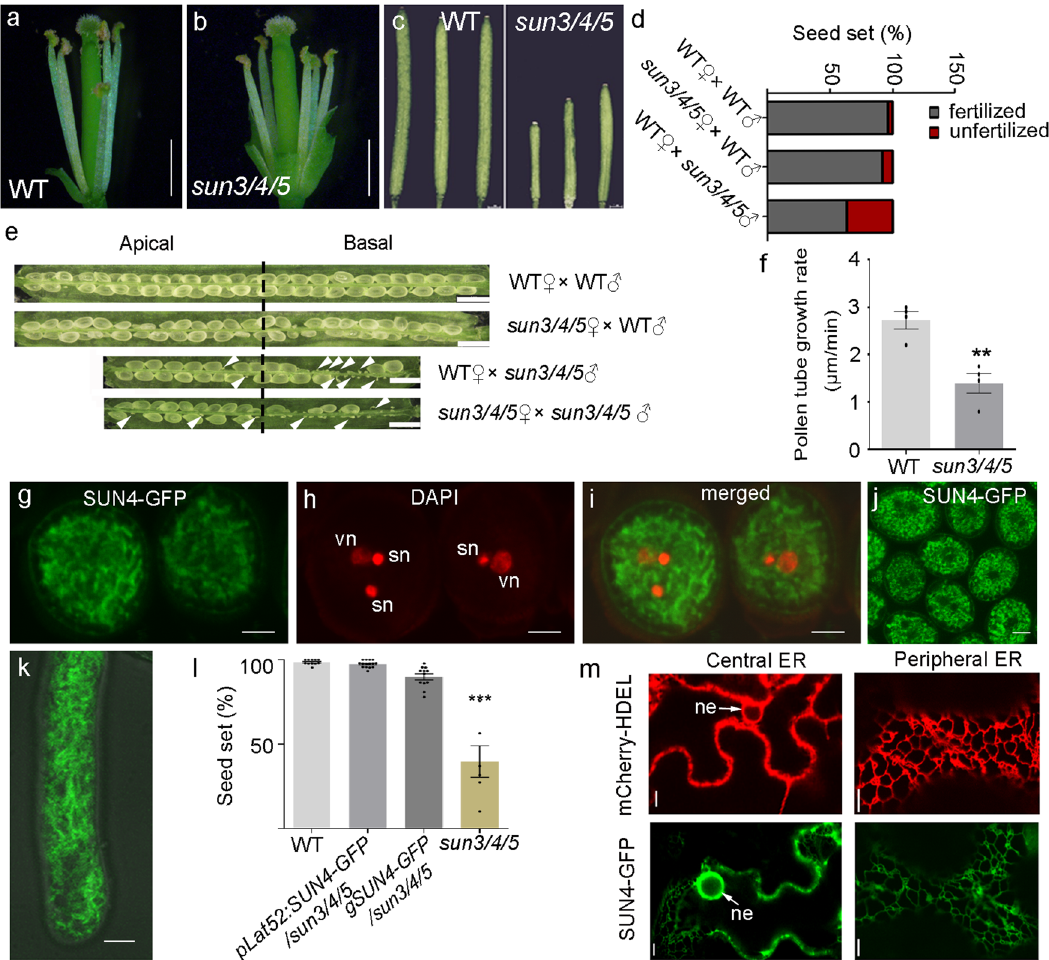
Fig. 2 Reproductive phenotype of sun3/4/5 . a Stamen fi laments in WT. b Stamen fi laments in sun3/4/5 . Bar, 1 mm. c The siliques are shortened in sun3/ 4/5 . The siliques are imaged 14 days after hand pollination. Bar, 1 mm. d , e Seed set of selfed and crossed sun3/4/5 . Arrowhead, aborted ovules. Bar, 1 mm. f Pollen tube growth rate. Bars represent means ± s.e.m. Two-tailed Student ’ s t -test, p ** = 0.0029, n = 4 pollen tubes of WT and sun3/4/5 , respectively, were measured. g – k Expression of SUN4-GFP driven by the LAT52 promoter in pollen grains. 6 independent biological experiments were repeated. g GFP channel. h DAPI staining showing the two sperm nuclei (sn) and vegetative nucleus (vn). i The merged image of g and h . j SUN4-GFP in pollen grains. k SUN4-GFP in pollen tubes. Bar, 5 μ m. l Genetic rescue of the sun3/4/5 by SUN4-GFP driven by the native promoter and LAT52 promoter, respectively. More than 30 siliques from 6 independent plants of each transgenic line were measured. The values represent means ± s.e.m., Two-tailed Student ’ s t -test, p *** < 0.001. m Expression of SUN4-GFP in tobacco leaf epidermal cells shows ER pattern like that of mCherry-HDEL marker. ne, nuclear envelope. Bar, 10 μ m. 6 independent biological experiments were